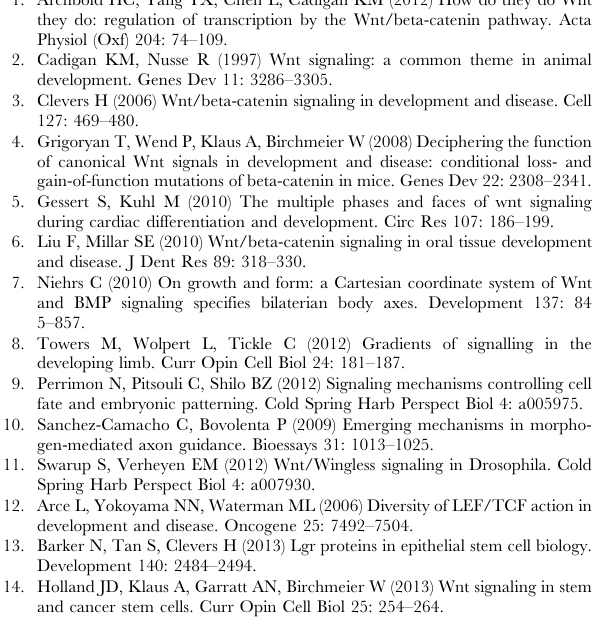
Figure S9 fd96Cb is activated by Wg signaling in the embryo. Bright field images of stage 13 embryos with in situ hybridization using dioxigenin-labeled probe complementary to the fd96Cb transcript. (A) Control embryos exhibited ventral stripes, similar to the fd96C W-CRM reporter. This expression was lost (B,C) or severely reduced (B 9 ,C 9 ) in embryos where arm RNAi (B,B 9 ) or TCF DN (C,C 9 ) were ubiquitously expressed via the da -gal4 driver. The percentage of embryos displaying reduced or complete loss of signal is indicated in the bottom right corner of each panel ( arm RNAi, n= 20; TCF DN n =52 embryos). (TIF) Figure S10 Wg expression in the ring gland using an affinity purified rabbit anti-Wg antisera. (B–B 9 ) Confocal images of Wg immunostains (red) and DAPI (blue) demonstrating Wg expression in the ring gland (bottom two rows). Omitting the 1 u antibody results in no signal (A). (TIF) Table S1 List of primers and probes used in cloning, site directed mutagenesis and EMSA binding assays.